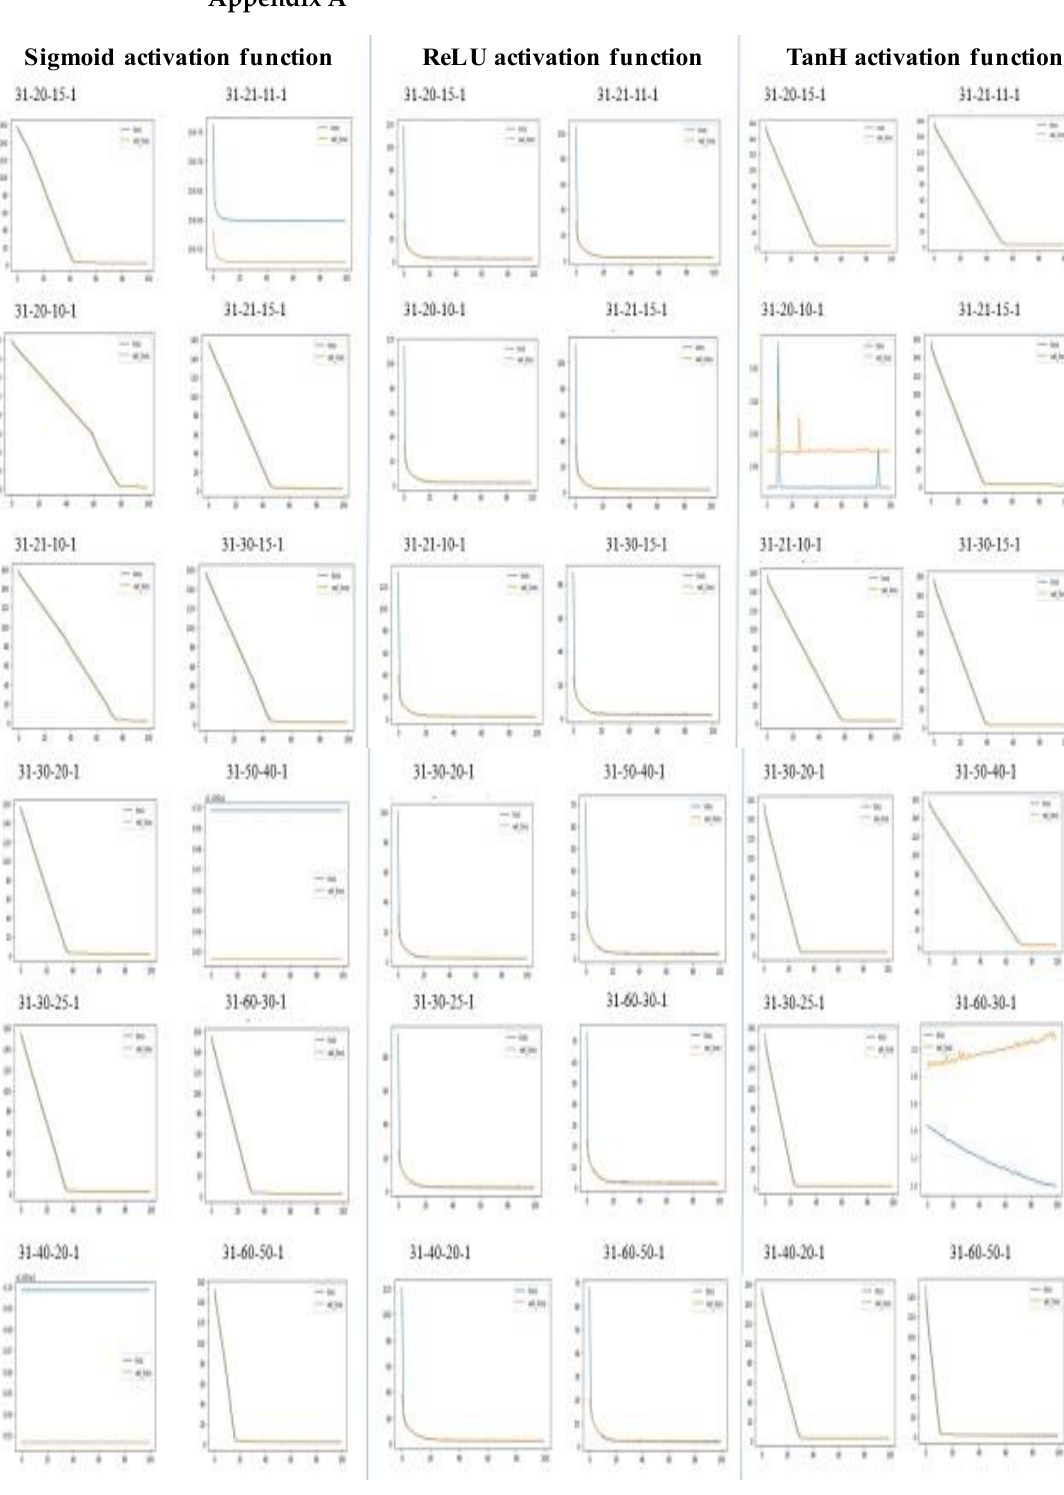
Figure A1. Training loss and Validation loss curves depicting the training performance of the models with three different activation functions for Ghaziabad and surrounding regions.